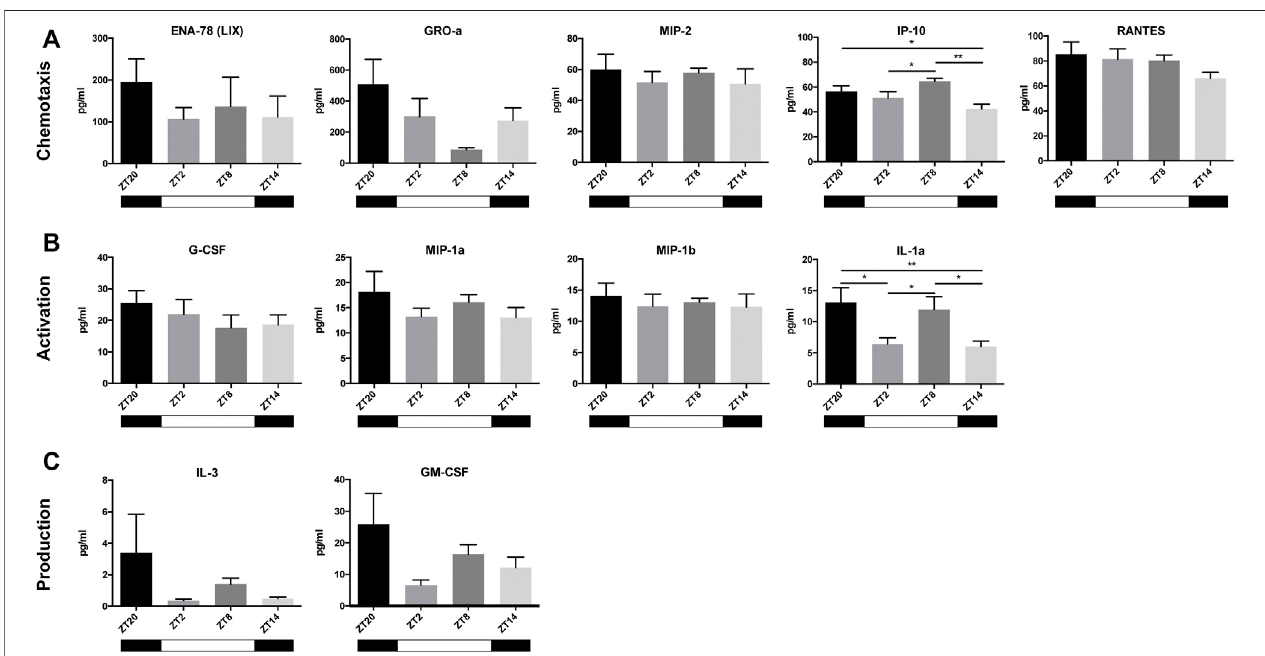
FIGURE 4 | Cytokines and chemokines in the blood after MI. Most chemokines involved in the chemotaxis of neutrophils (ENA-78, GRO-a, MIP-2, and RANTES) reached the highest plasma concentrations at ZT20, with the exception of IP-10, which peaked at ZT8 (A) Cytokines involved in neutrophil activation (G-CSF, MIP-1a, MIP-1b, and IL-1alpha) all peaked at ZT20 (B) Cytokines that play a role in the stimulation of neutrophil production and release (IL-3 and GM-CSF) peaked at ZT20 (C) ( n = 5 – 6 per group for all analysis) (* p < 0.05 , **p < 0.01 by one-way ANOVA with LSD